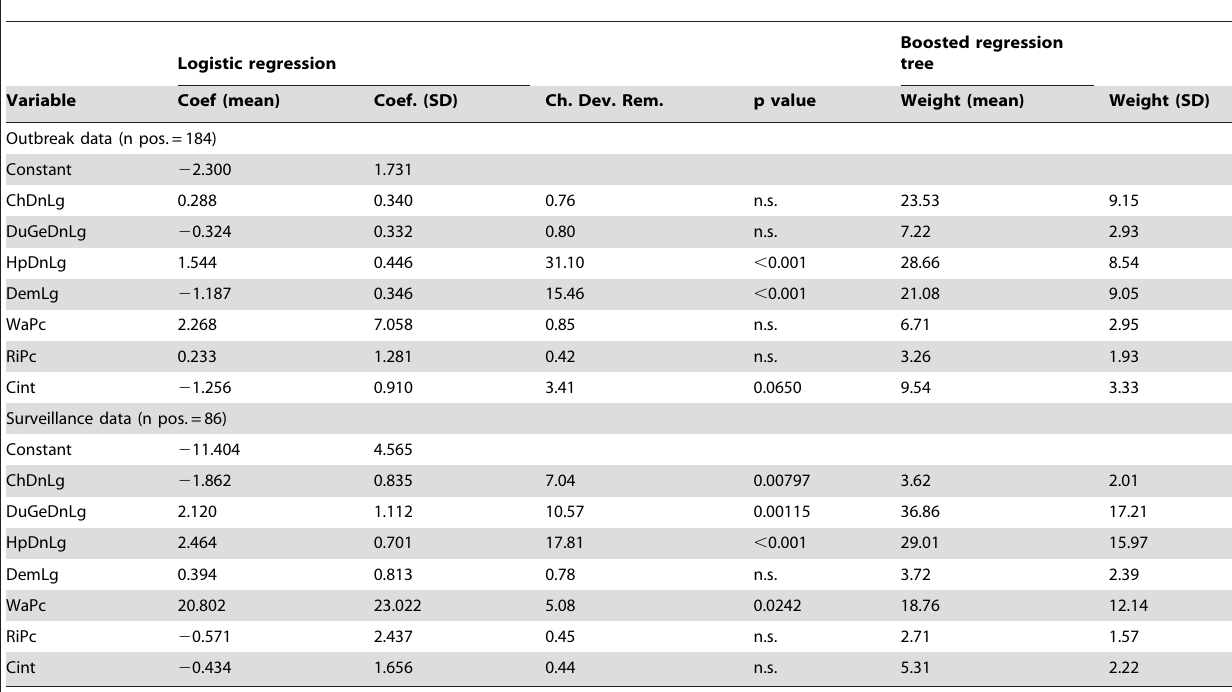
Table 2. Results of the bootstrapped logistic regression model and boosted regression trees applied to clinical HPAI H5N1 disease outbreak and HPAIV H5N1 serological surveillance